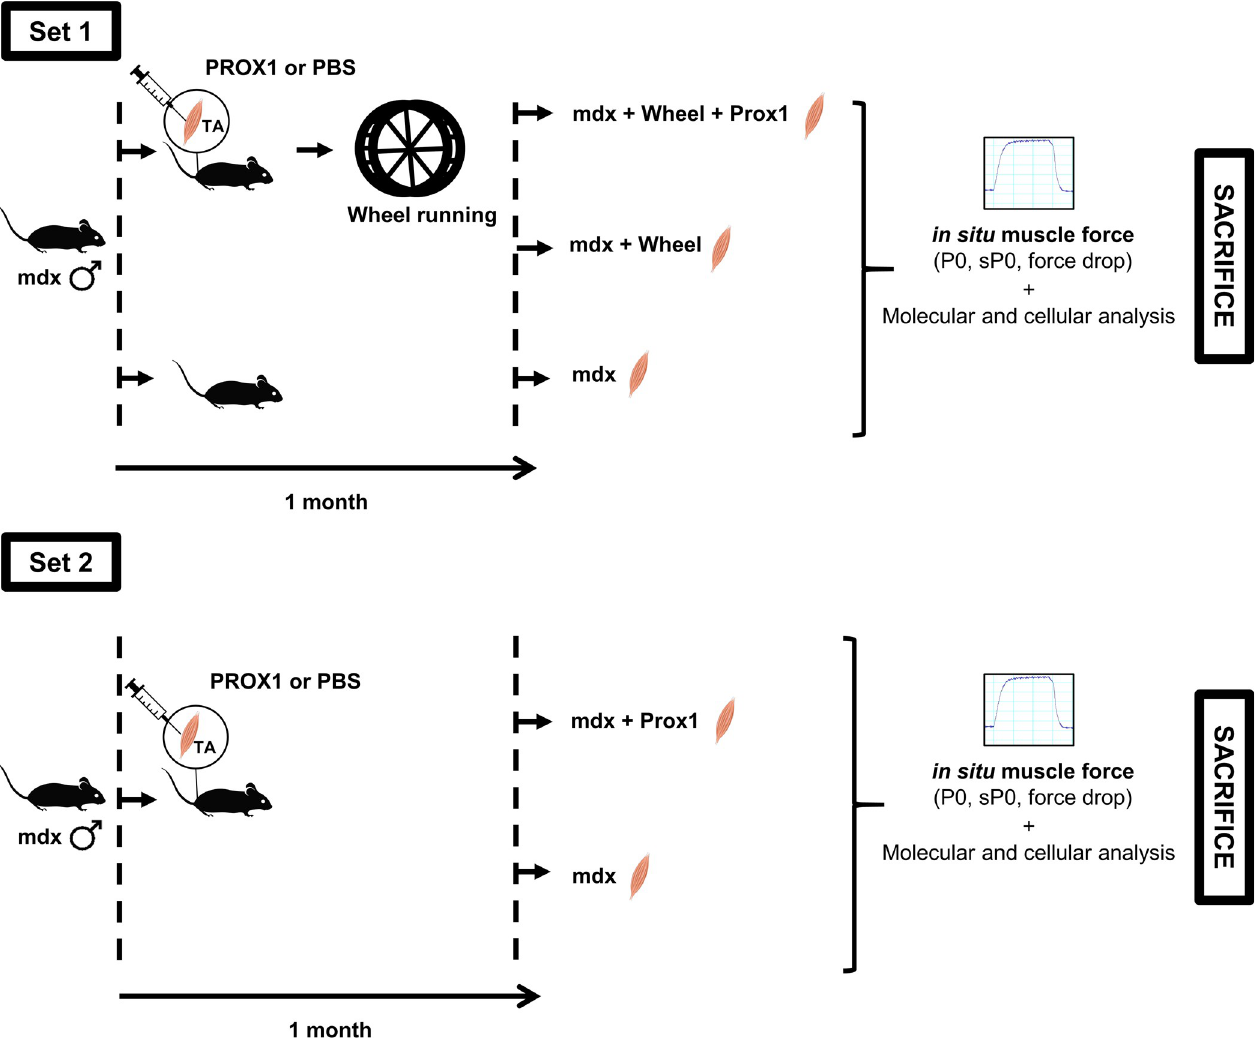
Fig 1. Experimental design. Two sets of experiments were performed. In the first set of experiment, we want to determine the effect of Prox1 transfer on fragility in voluntary exercised mdx mice. AAV-Prox1 and PBS were injected in TA muscles of the same mdx mice before voluntary exercise. The aim of the second set of experiment was to compare the effect of Prox1 transfer between voluntary exercised and sedentary mdx mice.